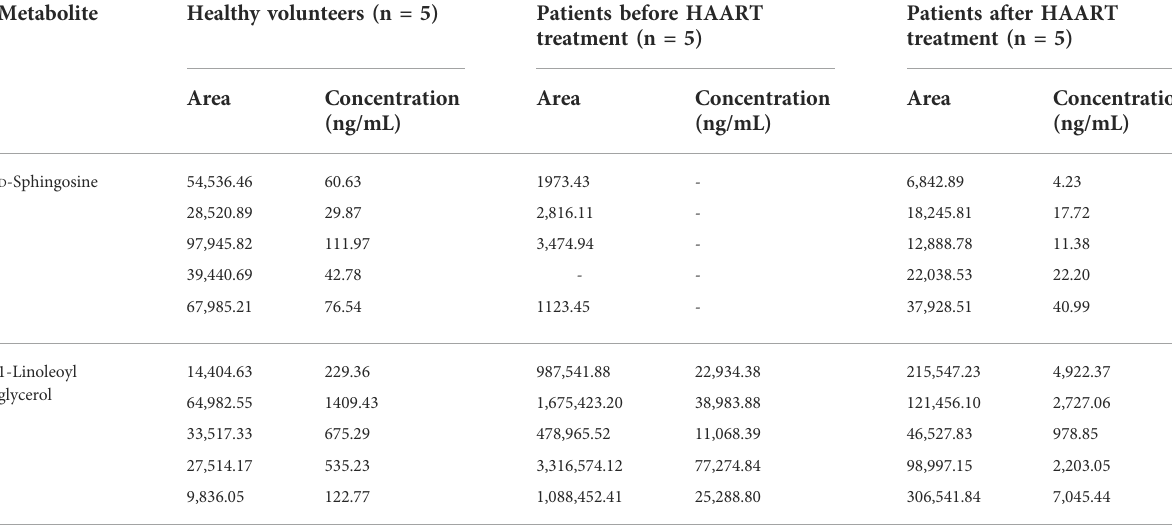
TABLE 4 The fold changes of the potential biomarkers between the patients before and after HAART treatment. Metabolite Healthy volunteers (n = 5) Patients before HAART Patients after HAART treatment (n = 5) treatment (n = 5) Area Concentration Area Concentration Area Concentration (ng/mL) (ng/mL)